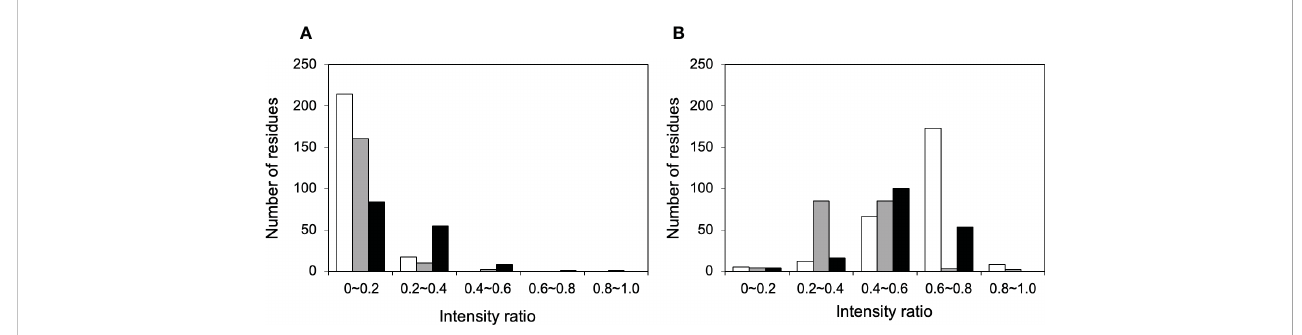
FIGURE 4 Histograms of the 1 H- 15 N HSQC peaks exhibiting attenuation in intensity upon addition of serum proteins. The residues showing different degree of peak attenuation by the addition of (A) polyclonal IgG-Fab and (B) HSA were counted for 15 N-labeled forms of rituximab-Fab (white), rituximab-Fc (black), and sFc g RIIIb (gray). The data were calculated from the spectra shown in Figure 3. The attenuation in intensity [( I o- I p)/ I o, where I o and I p are original peak intensity and intensity after perturbation, respectively] was calculated for all observable 1 H- 15 N HSQC peaks. The average levels of peak intensity attenuation caused by HSA were 0.60, 0.51, and 0.41 for rituximab-Fab, rituximab-Fc, and sFc g RIIIb, respectively, and those by polyclonal IgG-Fab are 0.33, 0.07, and 0.11 for rituximab-Fab, rituximab-Fc, and sFc g RIIIb,